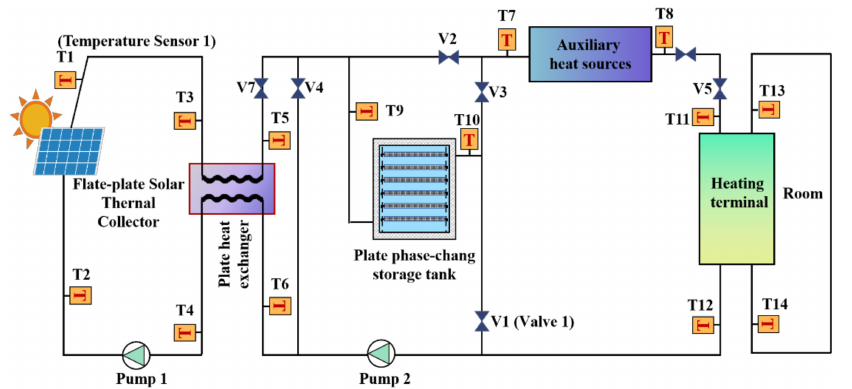
Figure 9. Schematic diagram of composite solar phase change heat storage combined with air-cooled heat pump heating